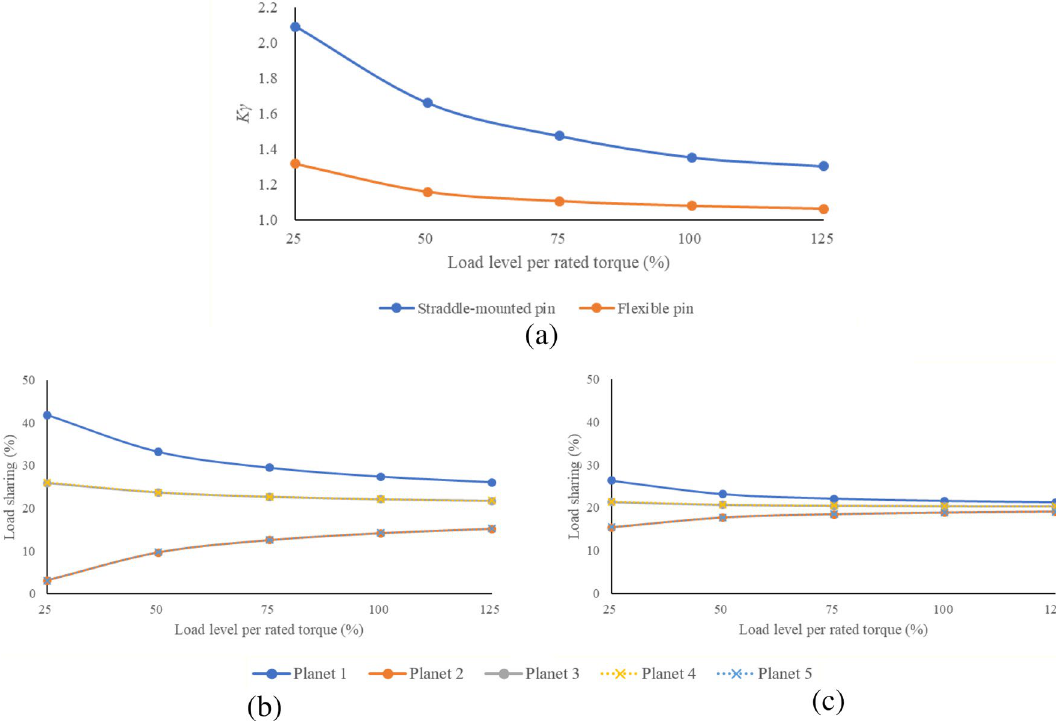
Figure 8. Load sharing performance of straddle-mounted pin and flexible pin under various load level: ( a ) load sharing ratio K γ , ( b ) load shared by each planet (straddle-mounted pin), and ( c ) load shared by each planet (flexible pin).